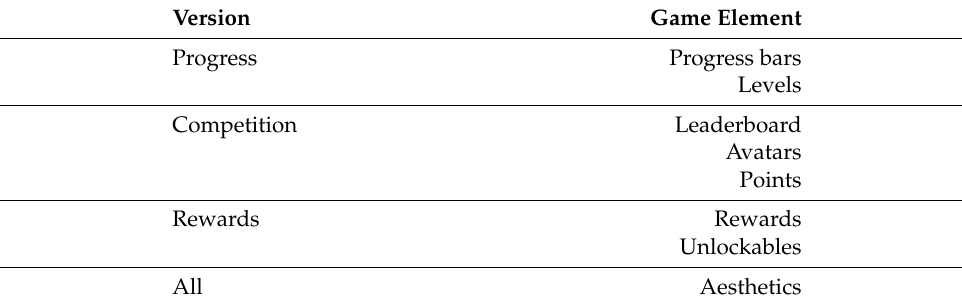
Table 5. Game elements present in each version of